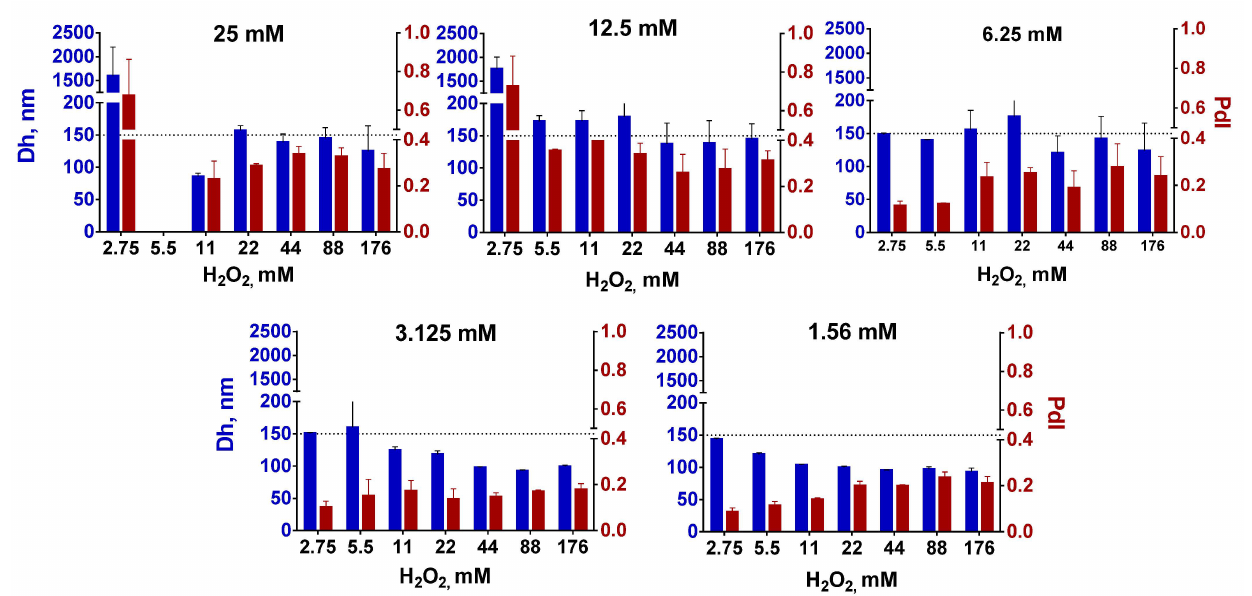
Figure 1. Size and polydispersity of Prussian blue nanoparticles prepared at different concentrations of FeCl 3 /K 3 [Fe(CN) 6 ] (shown above the histograms) and H 2 O 2 . Dh—hydrodynamic diameter (blue bars), PdI—polydispersity index (claret red bars). The dotted line at 150 nm is for easier visual comparison of samples. The absence of a bar means an aggregation of nanoparticles. n = 3, mean ±